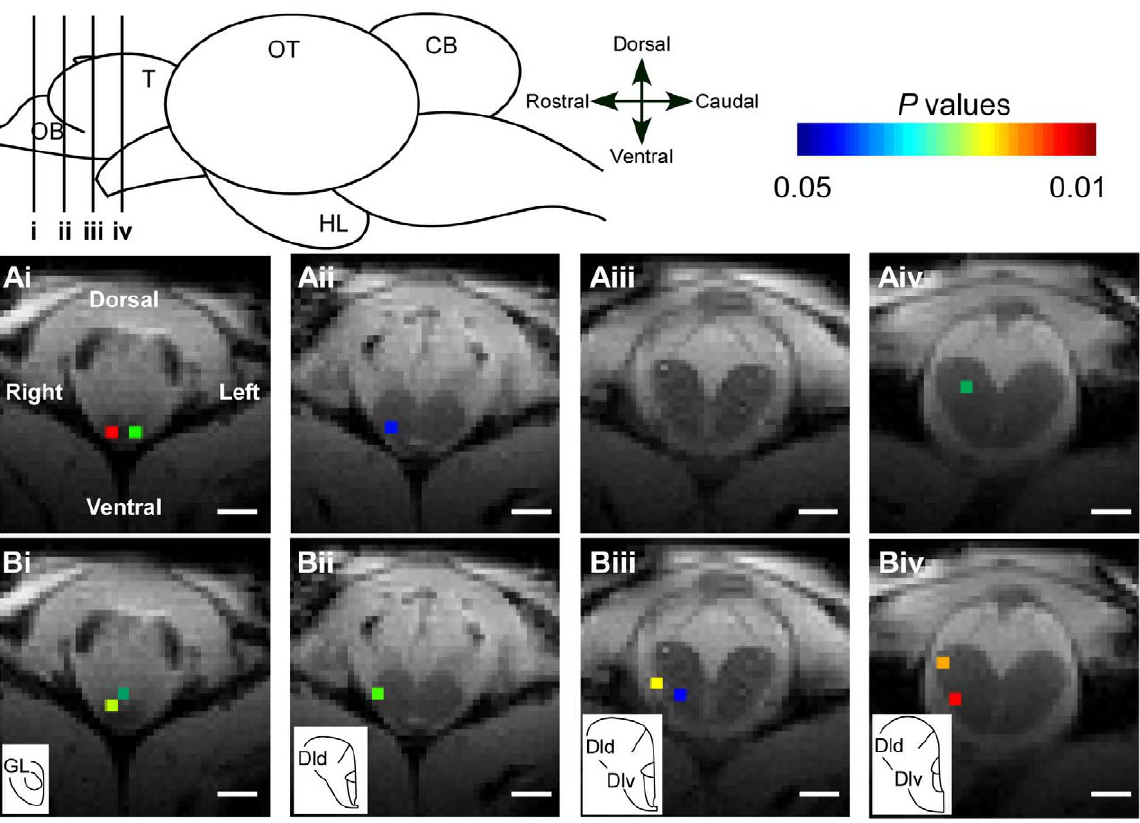
Figure 1. Blood oxygenation level-dependent (BOLD) functional magnetic resonance imaging (fMRI) maps of the same fish. A: L- serine; B: natal stream water. i: olfactory bulb; ii–iv: telencephalon. The activation map is defined by a threshold of P , 0.05 corrected for multiple comparisons using false discovery rate approach. The BOLD signals are overlaid on the anatomical MRI image. Scale bar=1.0 mm. CB, cerebellum; Dld, dorsal part of lateral area of dorsal telencephalon; Dlv, ventral part of lateral area of dorsal telencephalon; GL, glomerular layer; HL, hypothalamus; OB, olfactory bulb; OT, optic tectum; T, telencephalon.